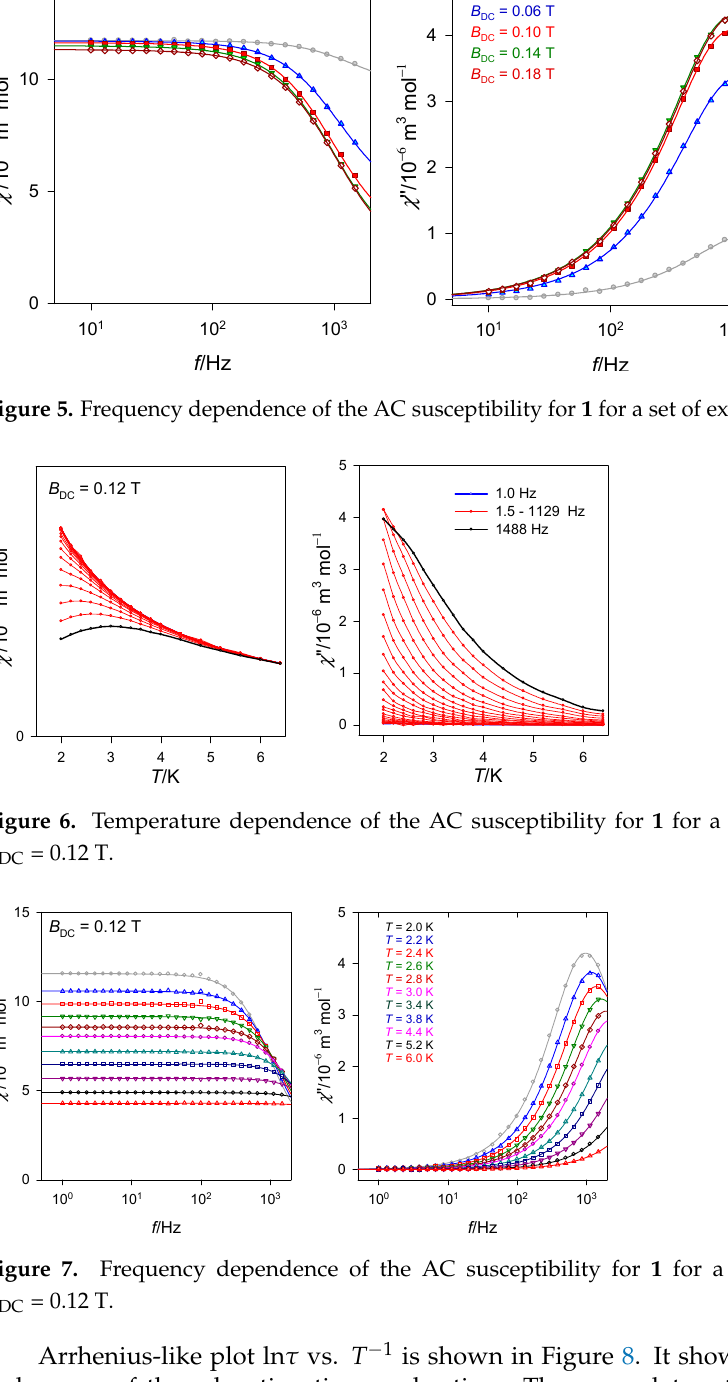
Figure 7. Frequency dependence of the AC susceptibility for 1 for a set of temperatures at B DC = 0.12 T.